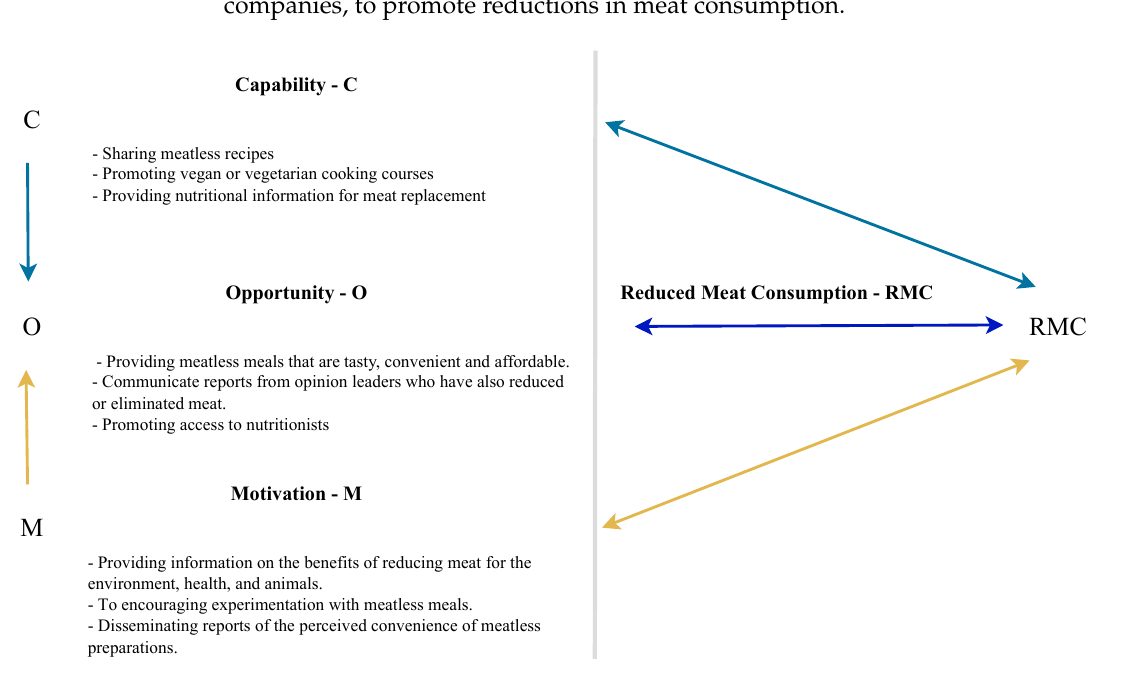
Figure 5. Proposed actions for consumers.